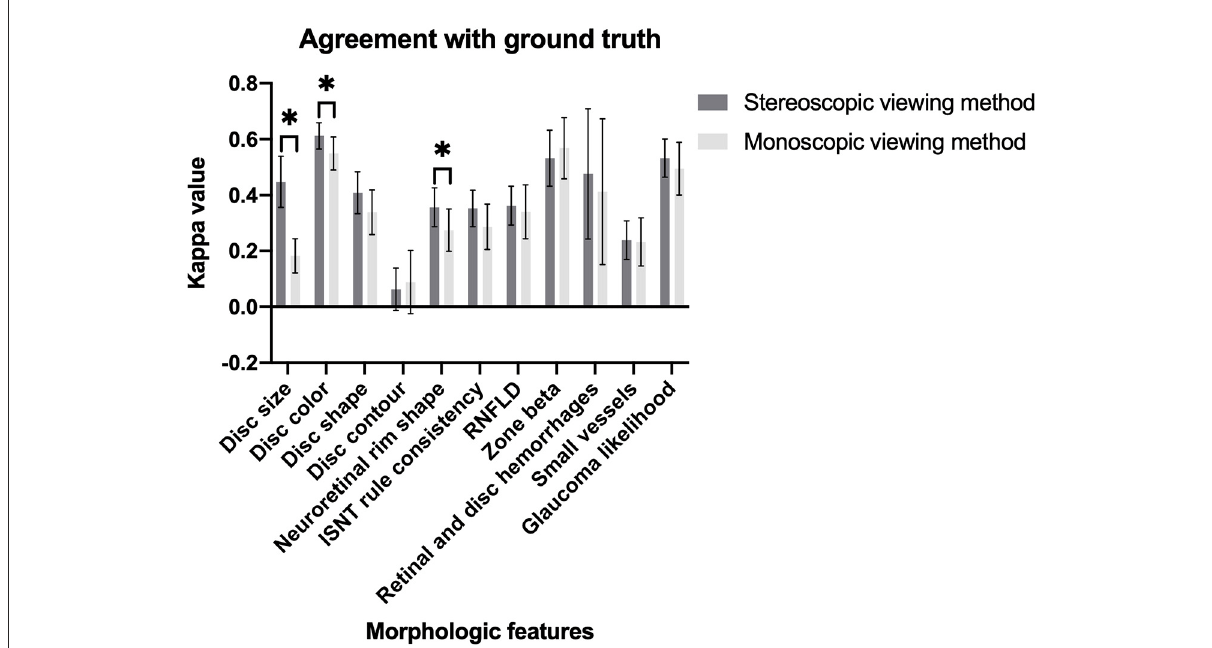
FIGURE2 Magnitude of agreement between two viewing methods and ground truth for morphologic features of optic disc and glaucoma likelihood (* P < 0.05).